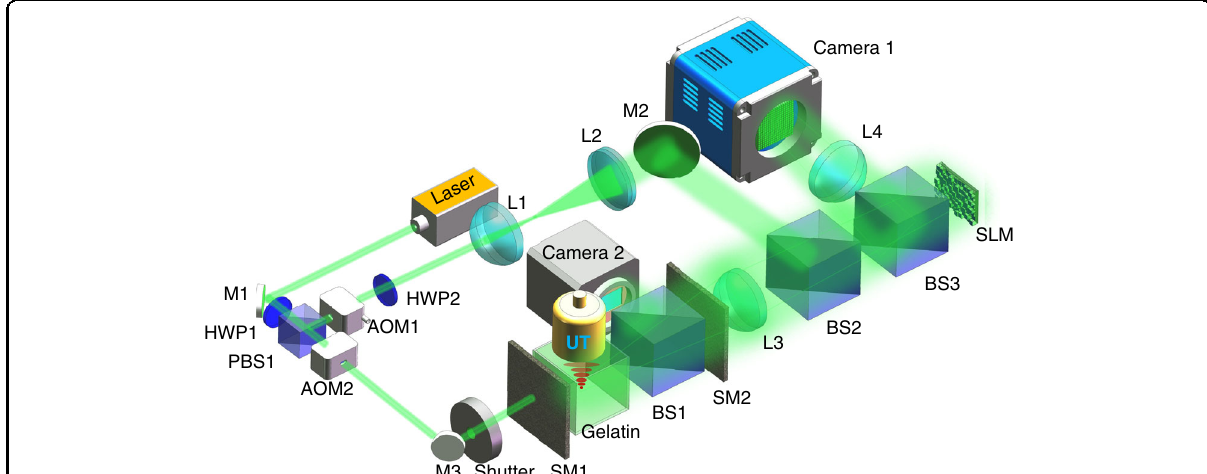
Fig. 3 Schematic of the experimental setup. AOM acousto-optic modulator, BS beam splitter (nonpolarizing), HWP half-wave plate, L lens, M mirror, PBS polarizing beam splitter, SLM spatial light modulator, SM scattering medium, UT ultrasound